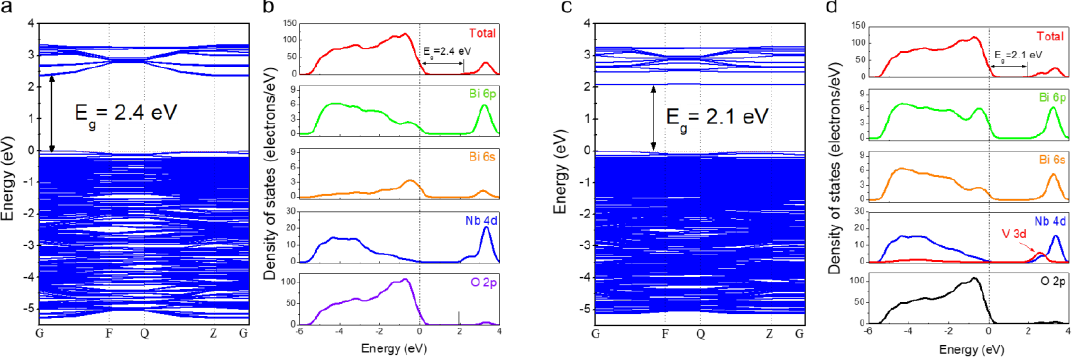
Figure 4. Electronic band structure and partial density of states (PDOSs) of SrBi 2 Nb 2 – x V x O 9 powders. ( a,b ) x = 0 (SBNV0) and ( c,d ) x = 0.6 (SBNV06).